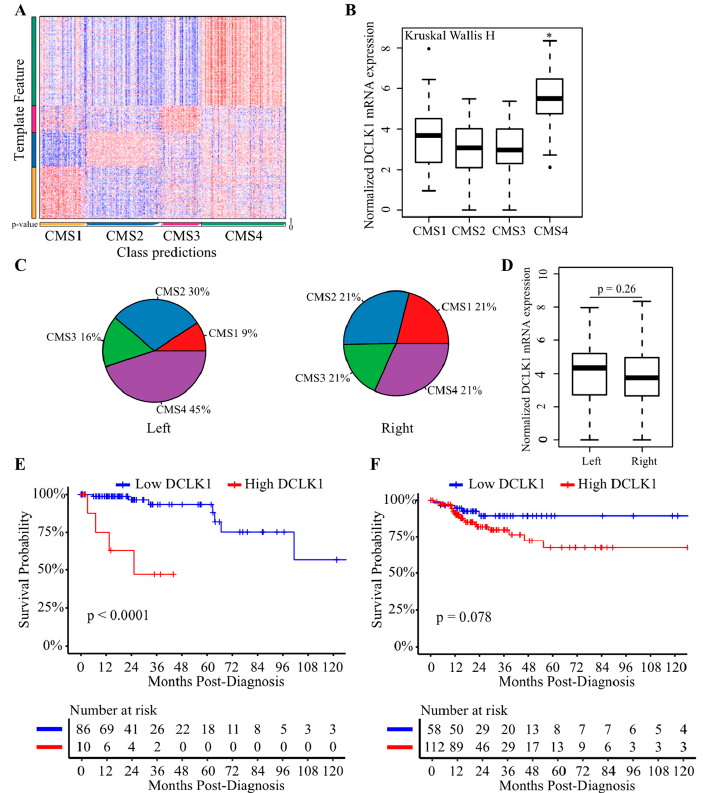
Figure 7. DCLK1 predicts DSS in the patients with left-sided colon cancer. ( A ) CMScaller performance on the test set of COAD from TCGA ( n = 283). Heatmap represents the relative expression levels of subtype marker genes (vertical bar) with classifications indicated below (horizontal bar, white indicates prediction confidence p -values). ( B ) DCLK1 expression level was significantly increased in CMS4 colon cancers. ( C ) Colon cancer initiated in the left colon (descending colon, sigmoid colon, and rectum) was more likely to present as CMS4 compared with those initiated in the right colon (caecum, ascending colon, and transverse colon). ( D ) DCLK1 mRNA level showed no significant di ff erence between left-sided and right-sided colon cancers. Higher DCLK1 expression predicts worse DSS in patients with cancers initiated in the left colon ( E ) but not in the right colon ( F ) based on Kaplan–Meier